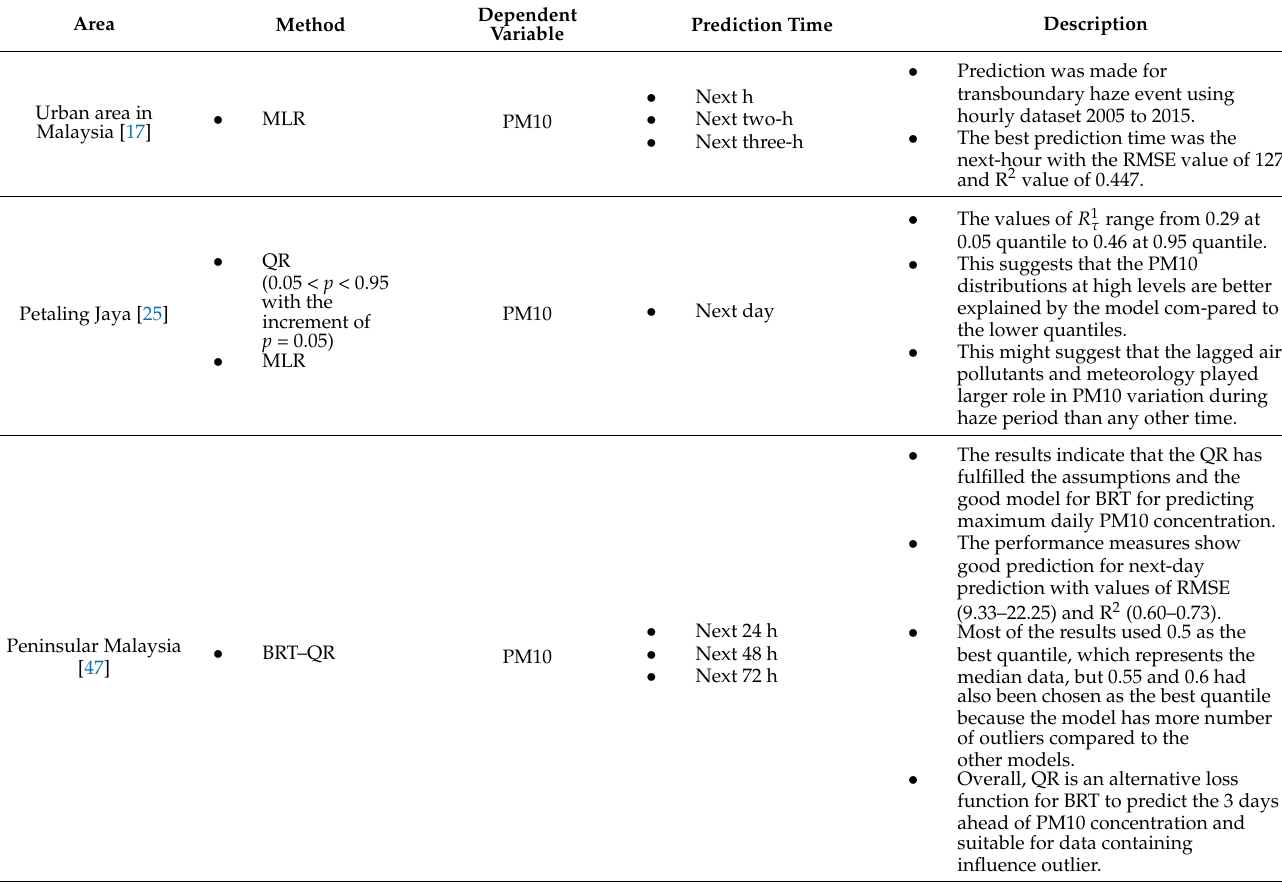
Table 10. Recent studies forecasting PM concentration during haze and typical atmospheric